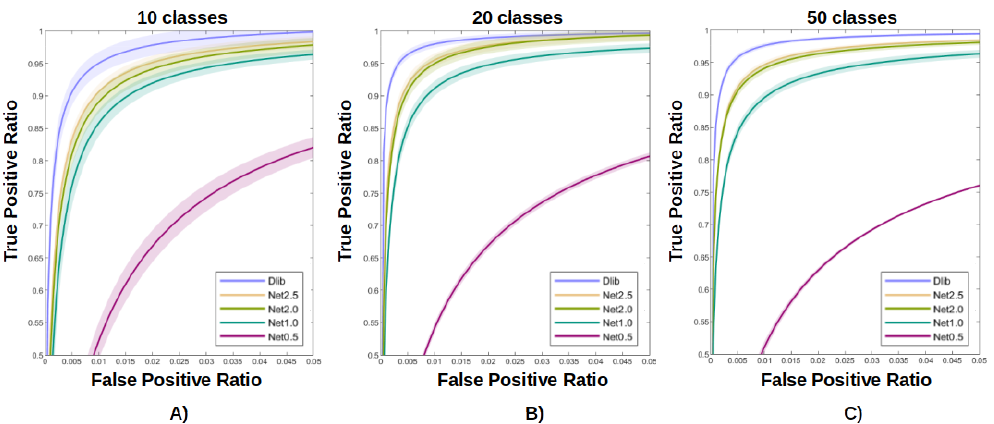
Figure 3. Performance evaluation of the different variants of the base distilled network [Net 0.5, Net 1.0, Net 2.0, Net 2.5] for the face recognition task in the case of 10 ( A ), 20 ( B ), 50 ( C ) classes. The procedure used was similar to the one described in section 2.4.2. The performance over # parameters ratio is extremely competitive for Net 2.0 (1.48 Mparameters), while Net 2.5 (3.94 Mparameters) provides only a limited amount of performance gain for its number of parameters with respect to Net 2.0.